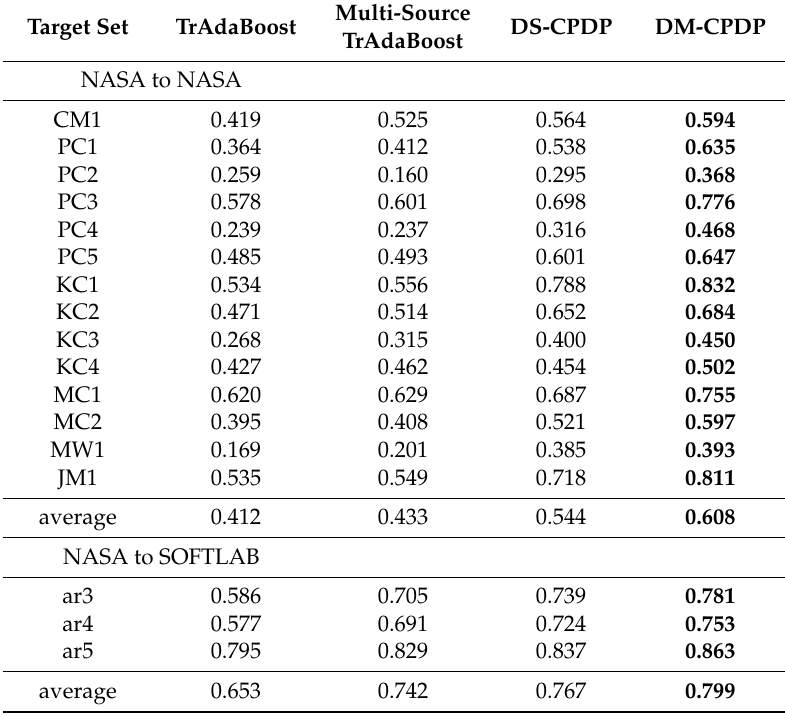
Table 7. F-measure value of different model construction methods. DS-CPDP: dissimilarity space based single-source CPDP.